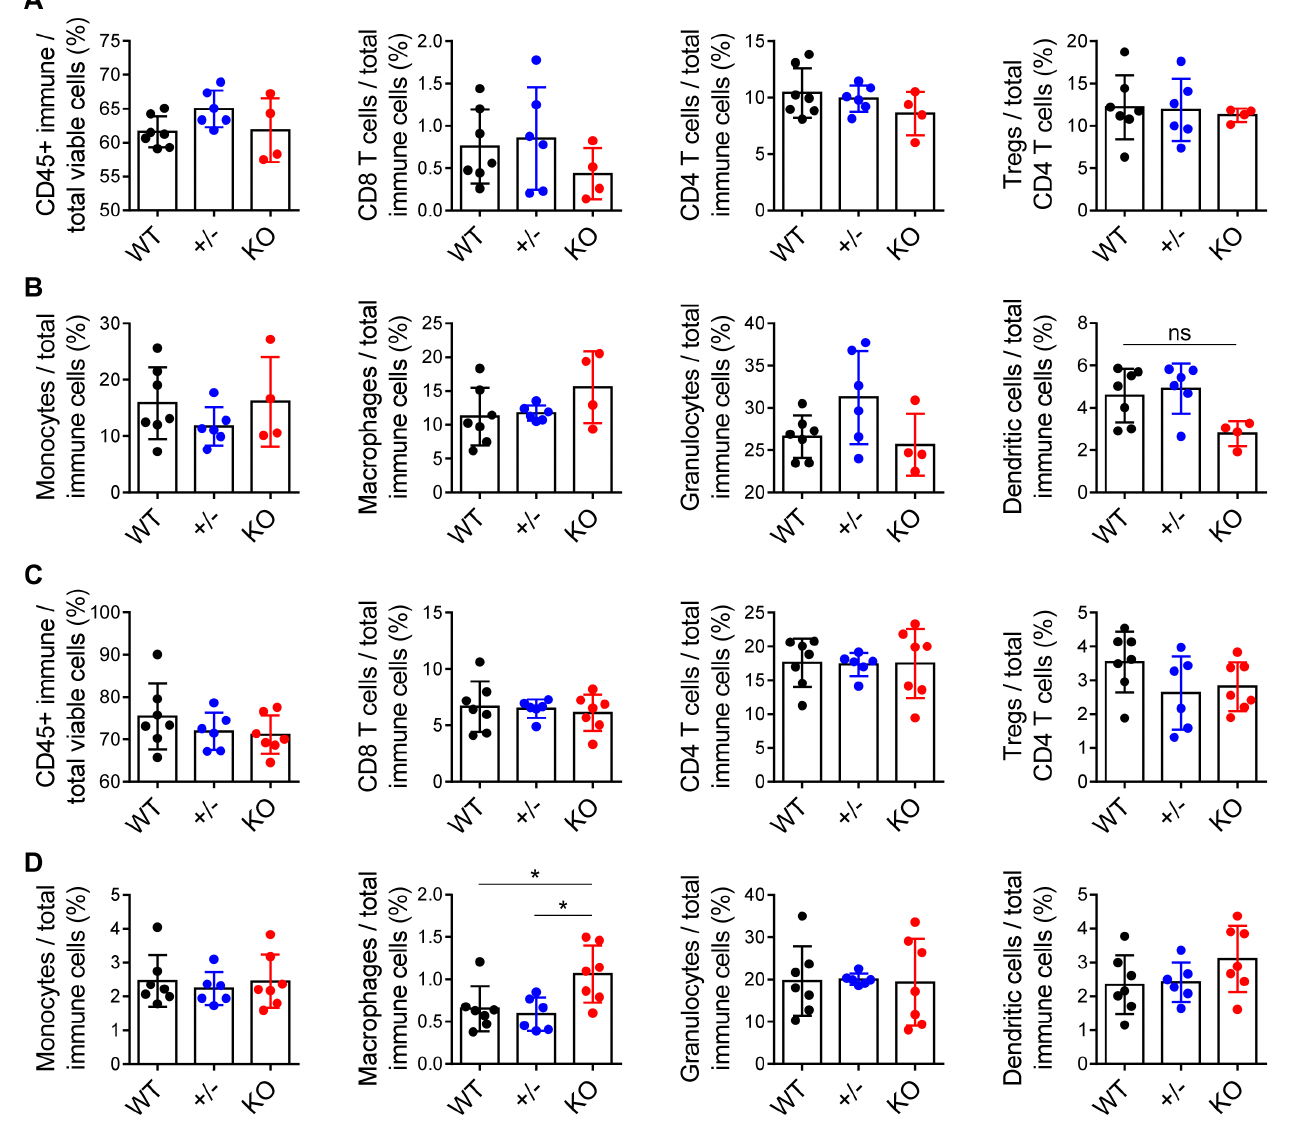
Figure 3. Tumor-infiltrating immune populations are not significantly different in ephrin-A1-deficient hosts. ( A ) Flow cytometric analysis of total immune cells, T cells, and T regulatory (Treg) cells, as well as ( B ) monocytes, macrophages, granulocytes, and dendritic cells, in 4T1 primary tumors resected from WT, +/-, and KO littermates at day 14 post-implantation. ( C , D ) Similar analyses of immune populations in tumor-bearing lungs harvested from WT, +/-, and KO littermates 17 days after tail vein injection of 4T1-GFP-luciferase cells. Data shown are averages ± SD with each data point representing an individual mouse ( n =3–7 mice per group). * p <0.05 (Kruskal-Wallis H -test with post-hoc unpaired Mann-Whitney U -test).